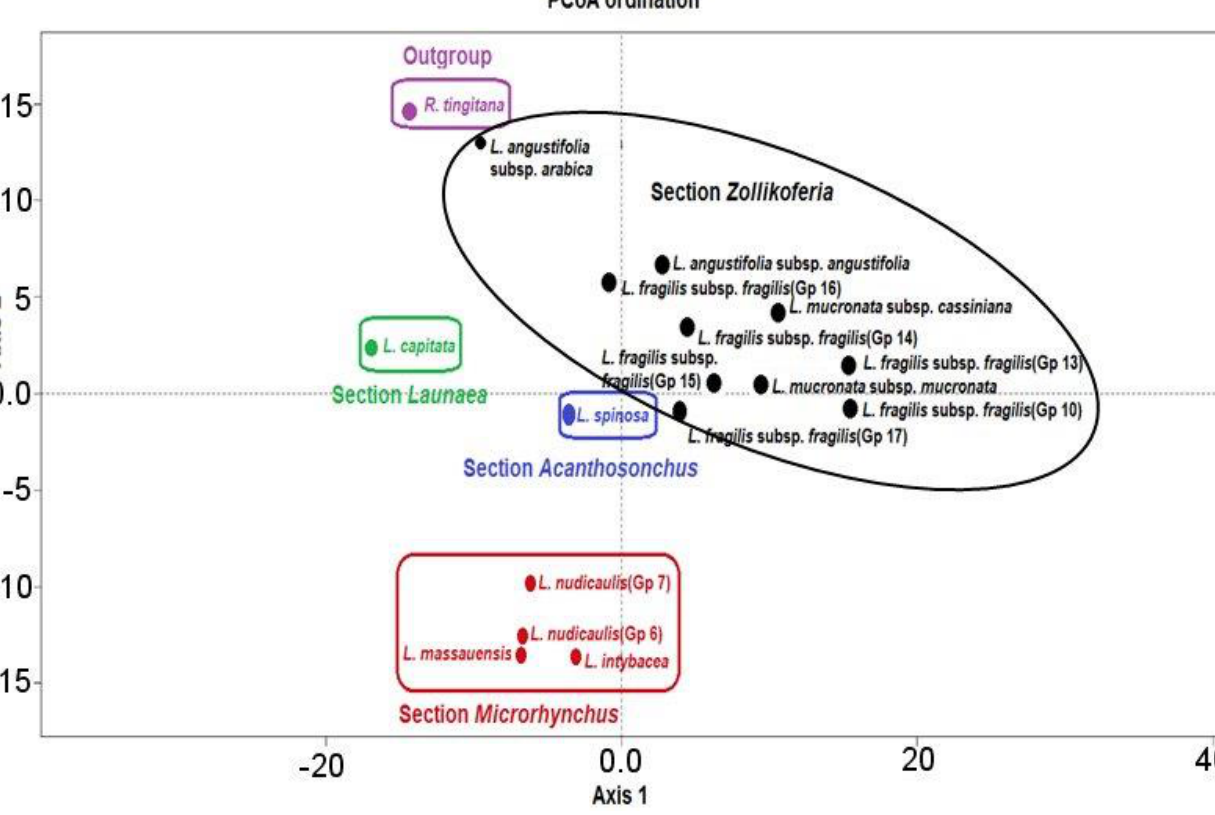
Figure 10. Principal Coordinate Analysis (PCoA) of seventeen samples representing the outgroup Reichardia tingitana and 10 taxa of Launaea based on the achene and the pollen grain micromorphological attributes.